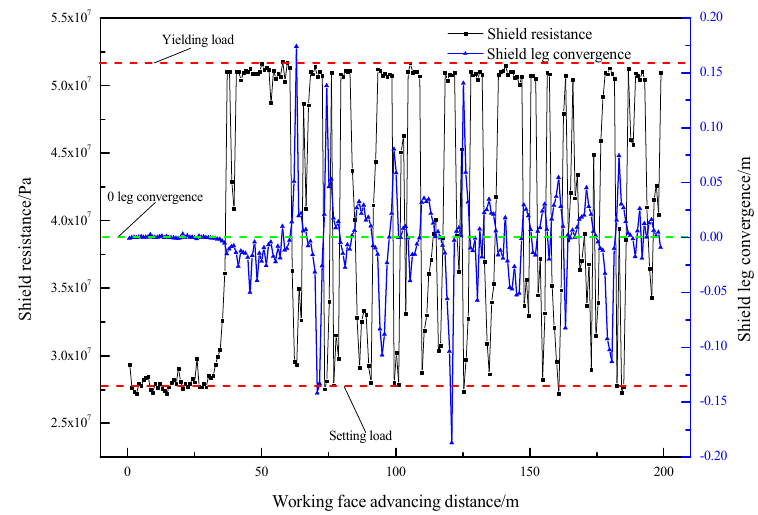
Figure 11. Changes of shield resistance and leg convergence under 6.5 m mining height. As shown in Figure 12, under 7.0 m mining height, the maximum shield resistance reached the yield load 52.8 MPa, the average shield resistance was 42.7 MPa, and the single maximum shrinkage of the shield column was 133.7 mm. The first weighting interval of the basic roof was 37.2 m, the periodic weighting interval of the basic roof was 8.5–11.5 m, and the average periodic weighting interval was about 9.5 m.